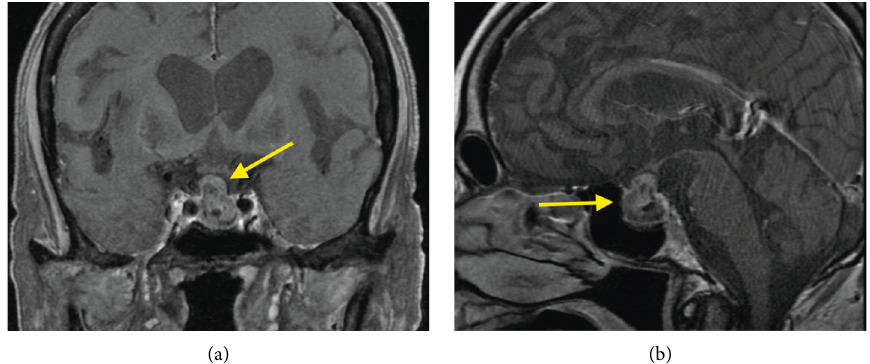
Figure 1: (a) Coronal and (b) sagittal views of the 2 cm pituitary